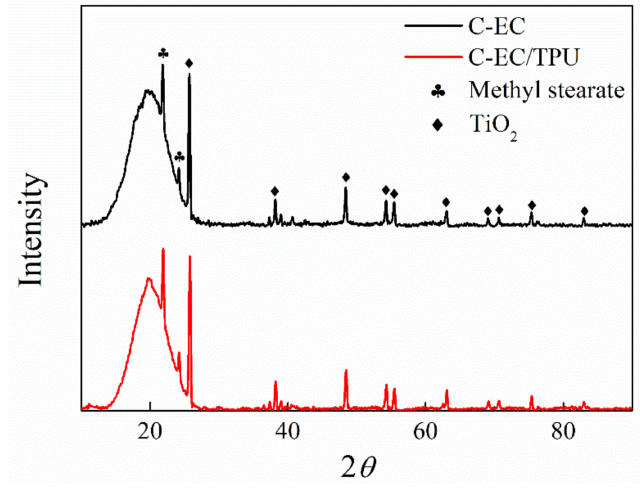
Figure 6. X-ray di ff raction pattern of the C-EC and C-EC /